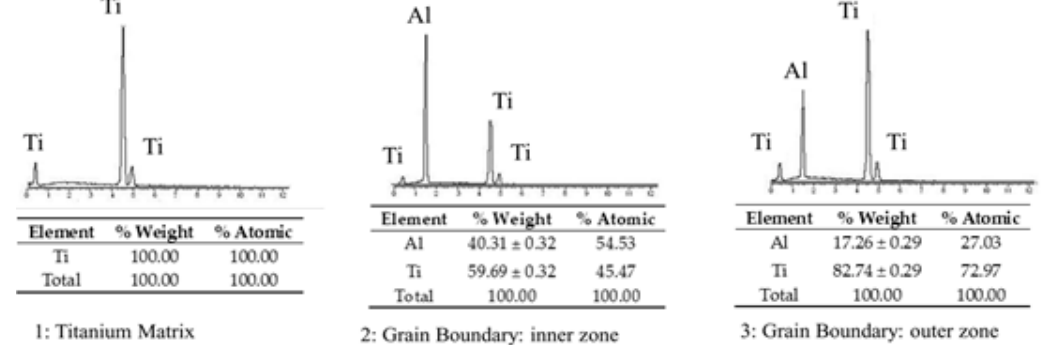
Figure 4. EDS analyses in principal spots at 1000 °C.